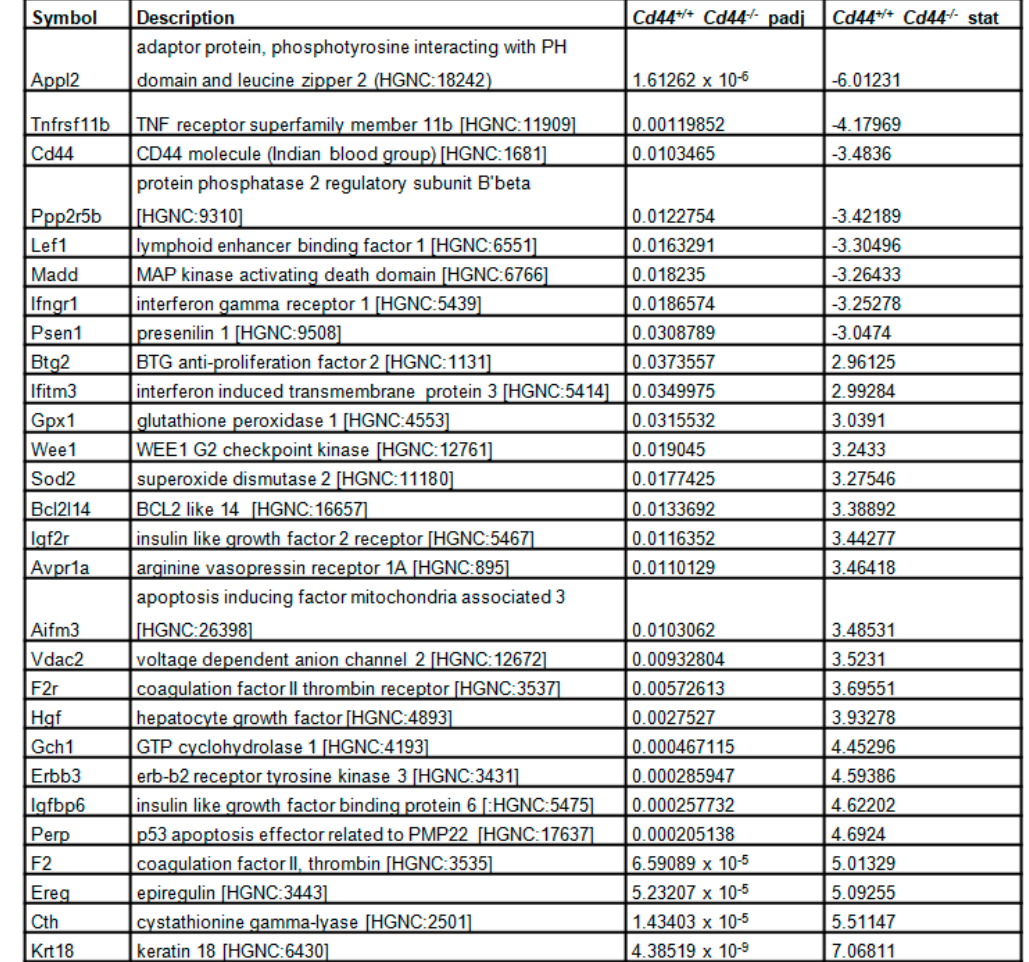
Figure 5. Gene expression analysis. ( A ) Principal component analysis (PCA) of RNA sequencing data. Data were plotted along the first and forth principal components. Each dot in PCA plot indicates a single sample. ( B ) Multivariate analysis of gene expression between Cd44 -positive and Cd44 -negative primary osteosarcomas. Unsupervised hierarchical clustering and heatmap showing Cd44 +/+ and Cd44 − / − primary osteosarcomas clearly segregated from one another, based on their RNA expression profiles. Three samples of each group were analyzed. Both downregulated (blue) and upregulated (red) RNAs were identified in Cd44 − / − osteosarcomas. The analysis was performed using an MADE4 package of R software. ( C ) List of apoptosis-related genes that are differentially regulated between Cd44 -positive and Cd44 -negative osteosarcomas. The data are represented as Wald-statistic (stat). Genes with negative Wald-statistic values are down-regulated in Cd44 − / − compared to Cd44 +/+ primary osteosarcomas, and genes with positive values are upregulated. Benjamin Hochberg adjusted p -value (padj) is indicated. Gene description source: HGNC (www.genenames.org/, accessed on 31 May 2022).